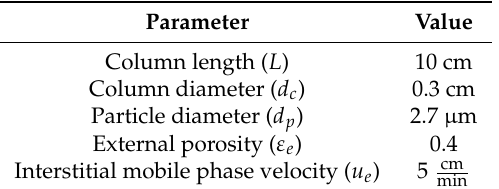
Table 1. The values of the numerical parameters necessary for the numerical